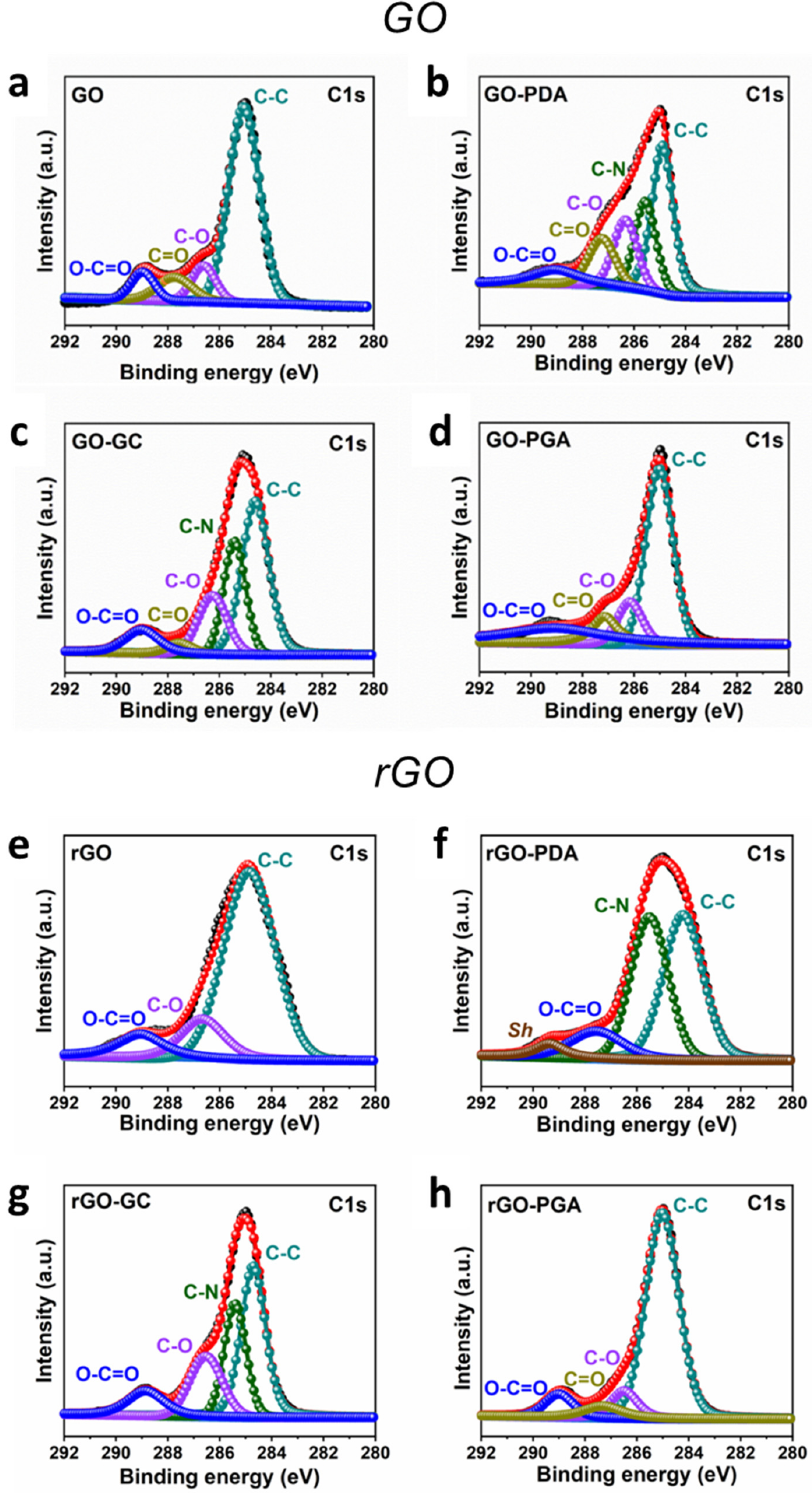
Figure 4. High-resolution XPS C1s spectra of GO ( a ), GO-PDA ( b ), GO-GC ( c ), and GO-PGA ( d ) and high-resolution XPS C1s spectra of rGO ( e ), rGO-PDA ( f ), rGO-GC ( g ), and rGO-PGA ( h ). The deconvoluted C1s profile of pristine GO (Figure 4a) shows complex surface chemistry corresponding to the presence of C–C (non-oxygenated C rings, 284.98 eV), C–